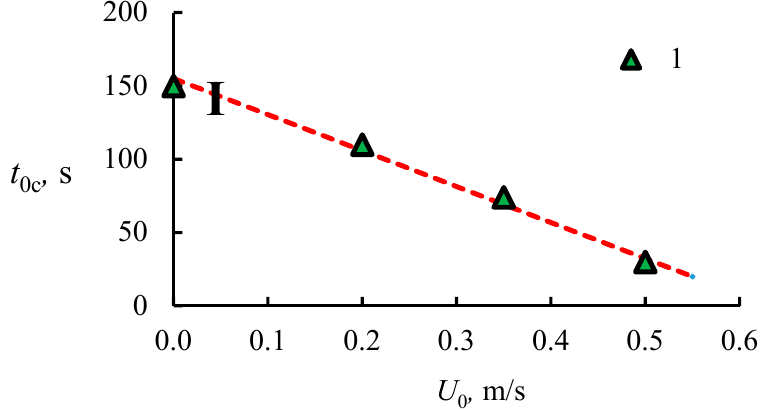
Figure 7. The ignition time t 0c depending on velocity of incoming air flow U 0 : (1—experimental data; 2 − t 0c = − kU 0 .